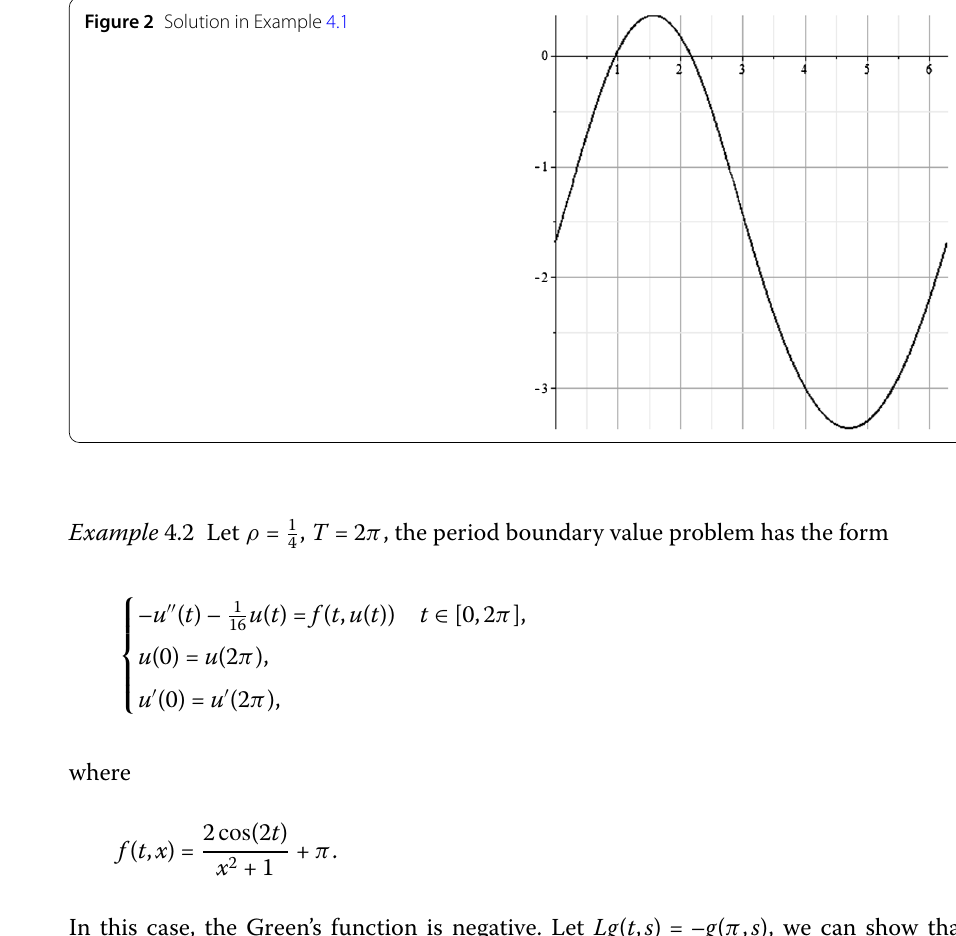
Figure 2 Solution in Example